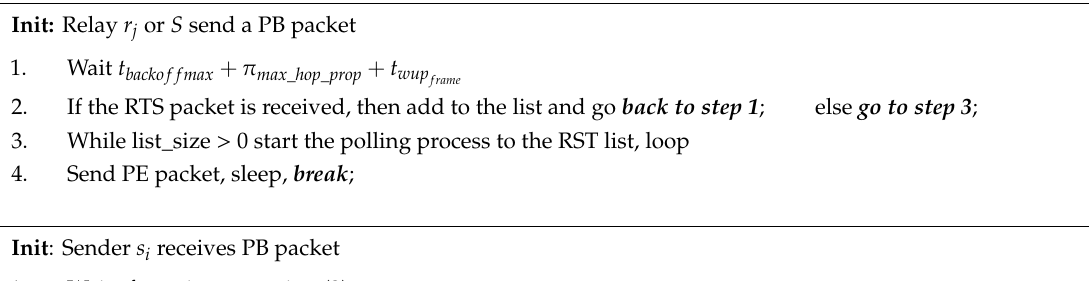
Algorithm 2. Polling